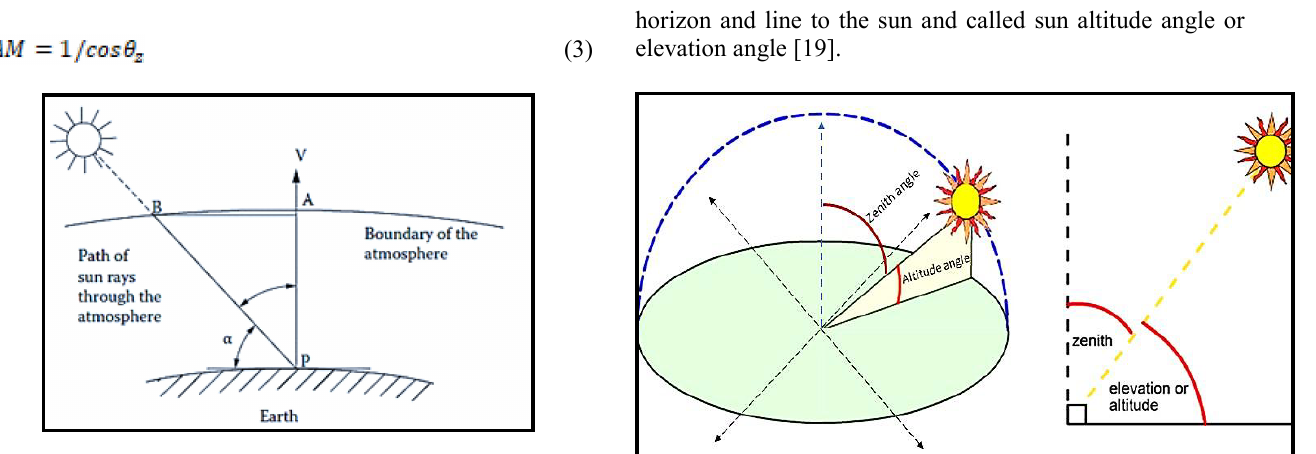
Figure 4. Solar zenith angle and altitude angle [13].